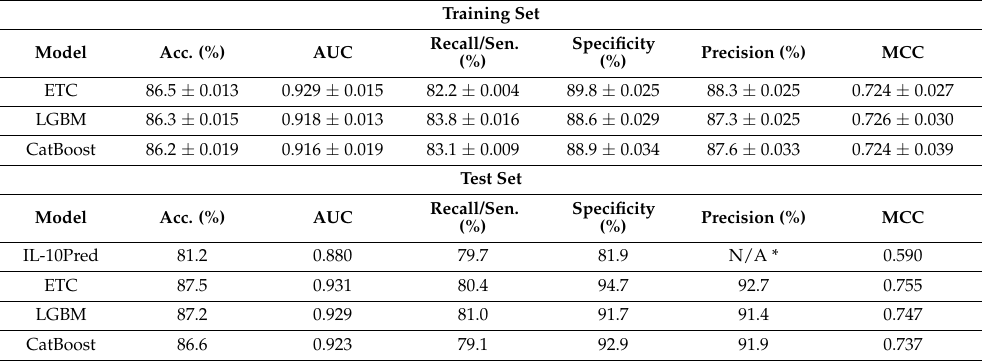
Table 2. Performances and comparison with state-of-the-art machine learning models based on hybrid features for the benchmark training and test datasets. The values shown are mean ± standard deviation for the training